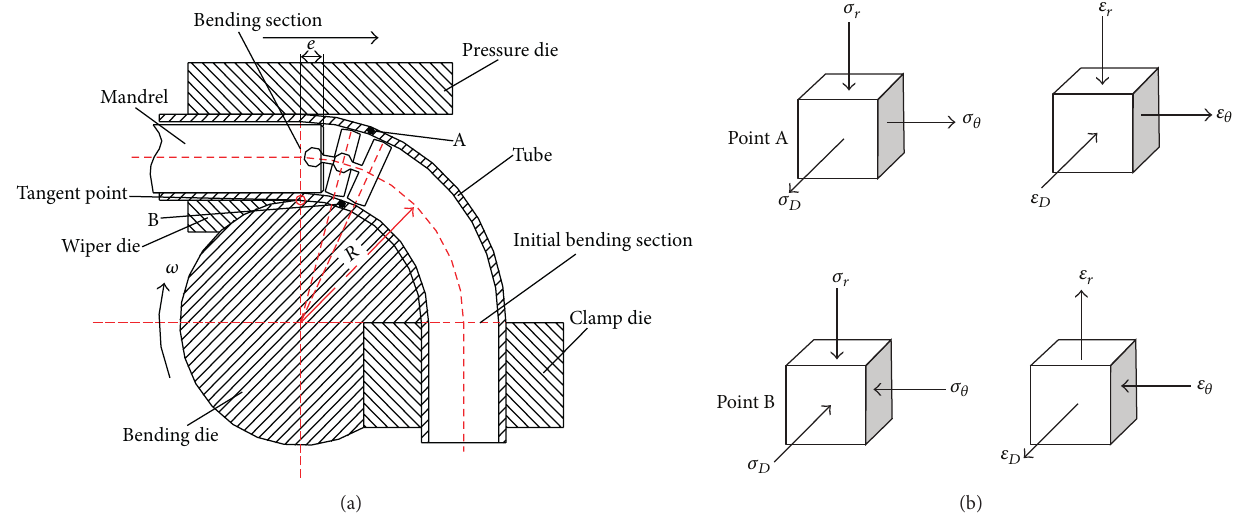
Figure 1: Sketch of the NC bending process (a) and stress stain state (b).